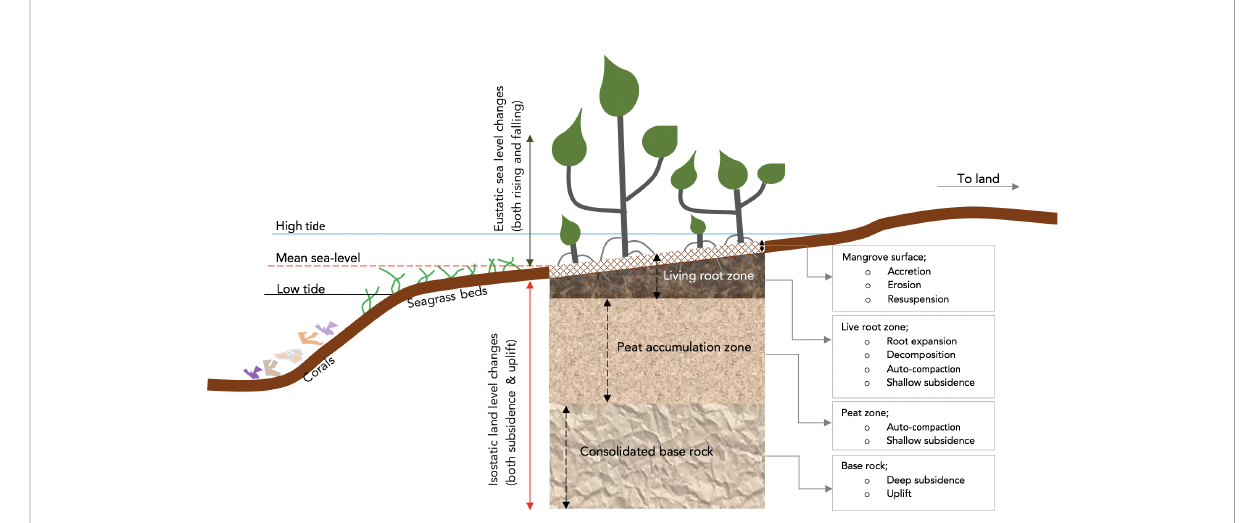
FIGURE 1 Diagram showing the regional and localized dynamic processes controlling both the short- and long-term mangrove surface